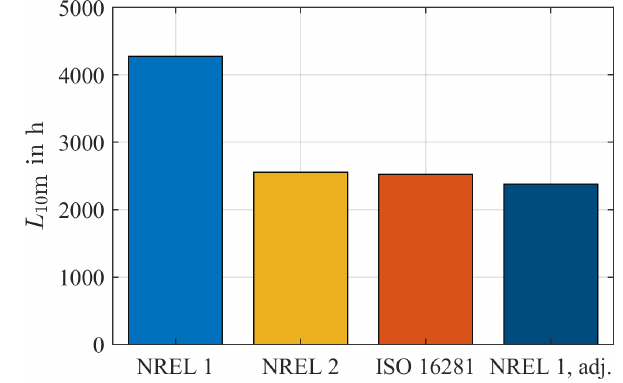
Figure 13. Fatigue lifetimes of all methods investigated.